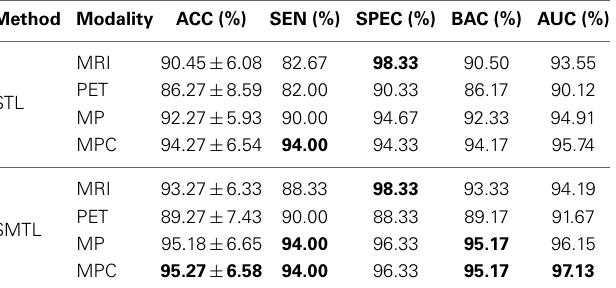
Table 5 | A summary of the performances for AD vs. MCI classification.